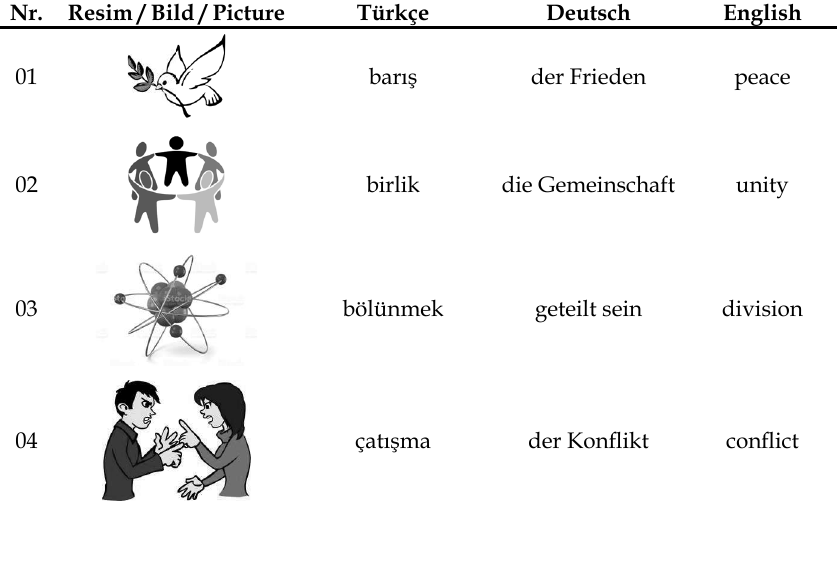
Table 2 . First group of words for